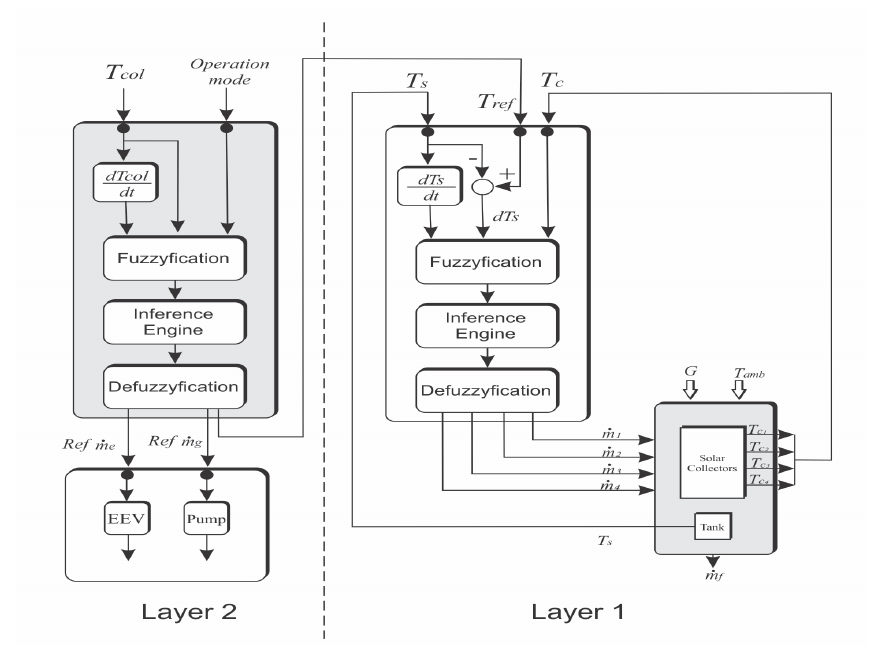
Figure 2. Fuzzy control of supervisory ejector cycle and multi-solar collector systems.